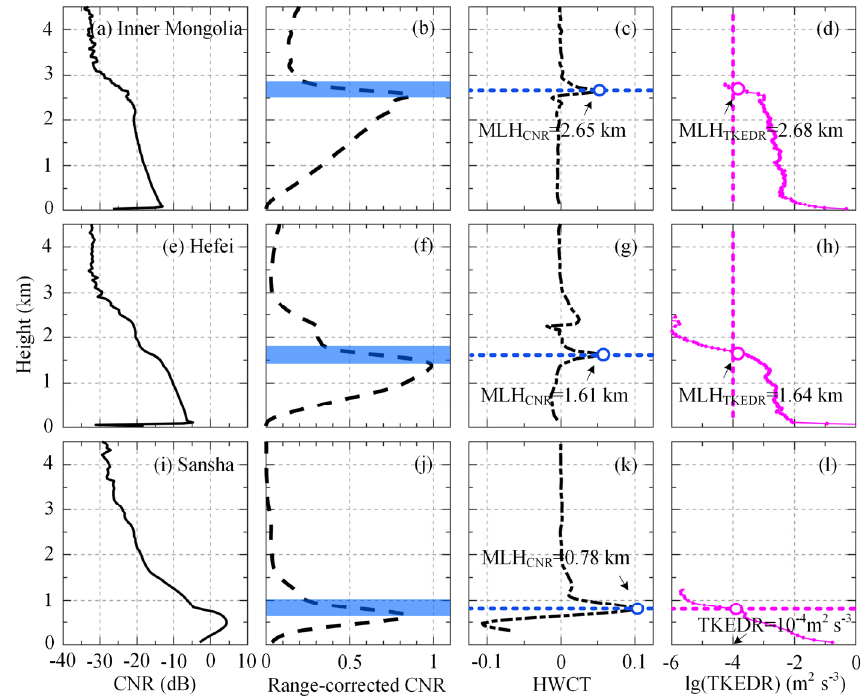
Figure 2. ( a ) CNR, ( b ) normalized range-corrected CNR and its ( c ) HWCT, ( d ) lg(TKEDR) profiles at 1202 LST on 27 September 2019 in Inner Mongolia. ( e – h ) is at 1208 LST on 12 May 2019 in Hefei. ( i – l ) is at 1209 LST on 10 November 2018 in Sansha. Blue circle and pink circle denote the MLHs retrieved from CNR and TKEDR, respectively.